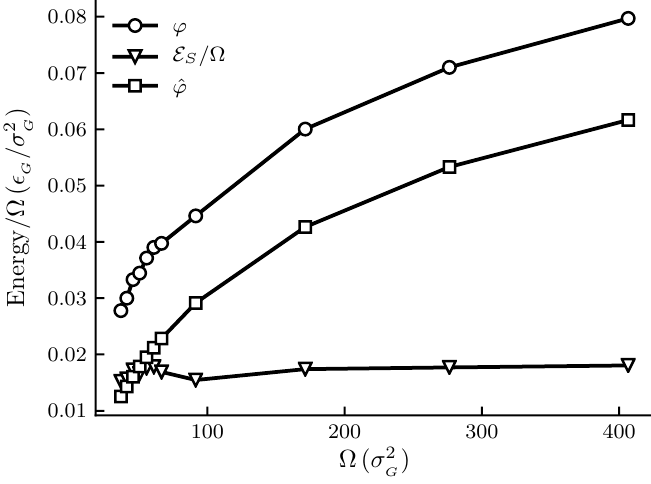
Figure 1. Film properties ϕ , ˆ ϕ and E s / Ω for the graphite adsorbent case as functions of the adsorbent area Ω at constant temperature T = 1.080 and pressure p = 0.011. All quantities are given in reduced units. For reference, the approximate values in SI units are T ≈ 250 K, p ≈ 1.05 MPa and adsorbent radii are between 6 and 25 × 10 − 10 m. The markers indicate which adsorbent sizes were simulated and the lines are there as visual